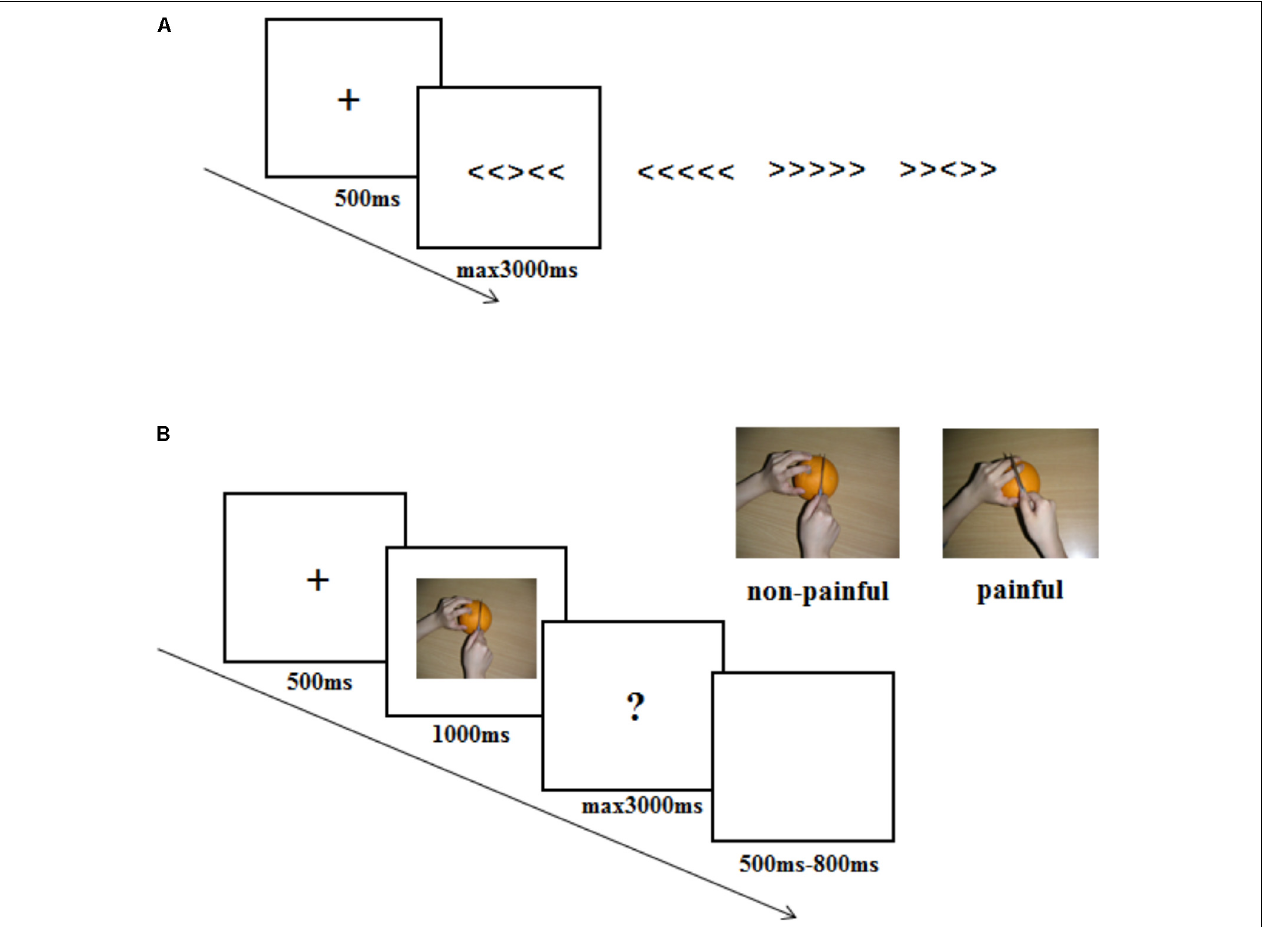
FIGURE 1 | Illustration of the stimuli and experimental procedure used in the current study. (A) stimuli used and timing of events in one trial in the Eriksen Flanker task. (B) stimuli used and timing of events in one trial in the ERP experiment